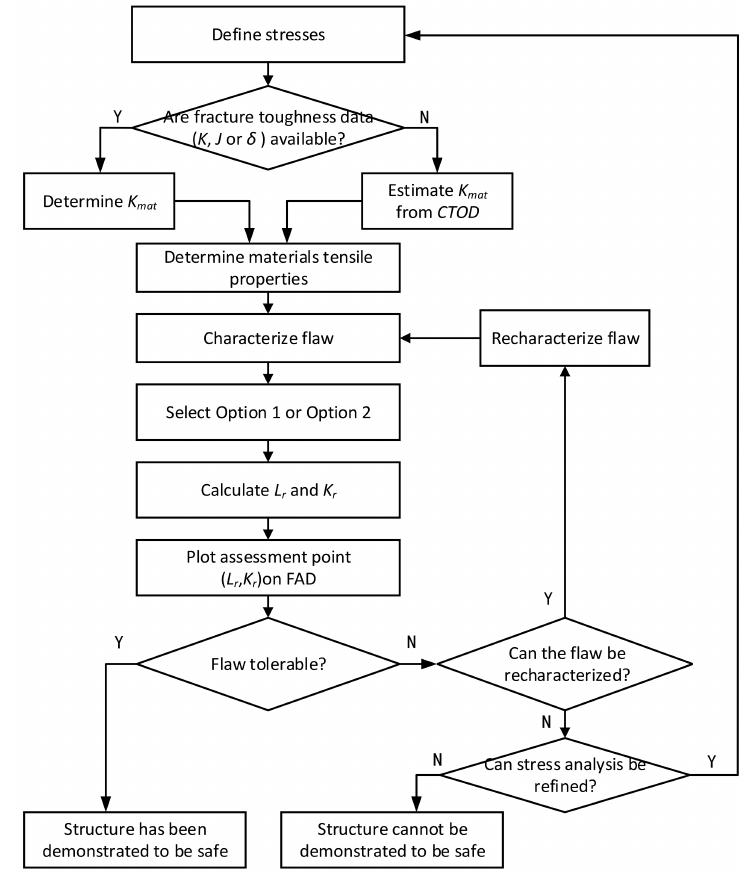
Figure 2. FAD Evaluation Process based on BS